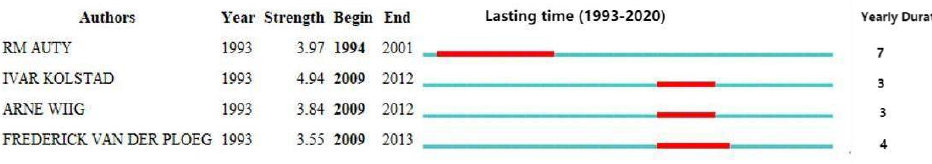
Figure 11. Authors with occurrence explorations during 1993–2020.